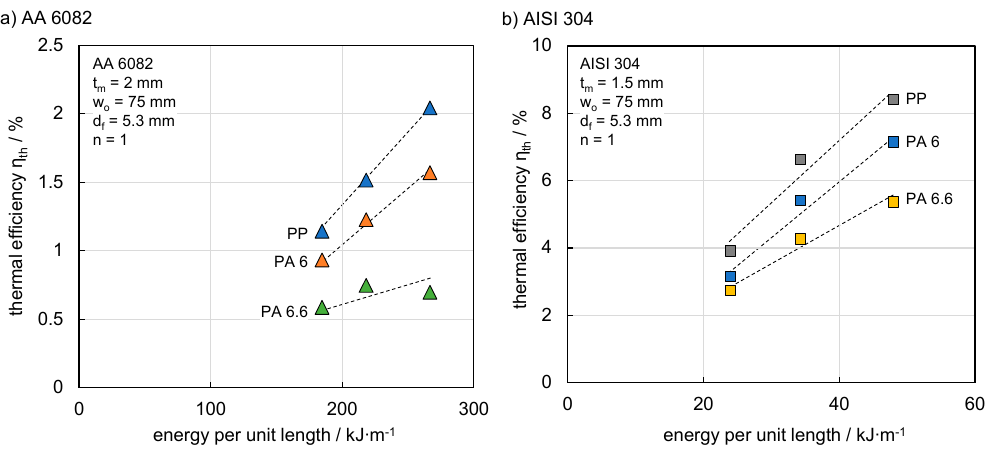
Figure 7. ( a ) E ff ect of polymer material on thermal e ffi ciency for AA 6082 and ( b ) AISI Figure 7. ( a ) Effect of polymer material on thermal efficiency for AA 6082 and ( b ) AISI 304.